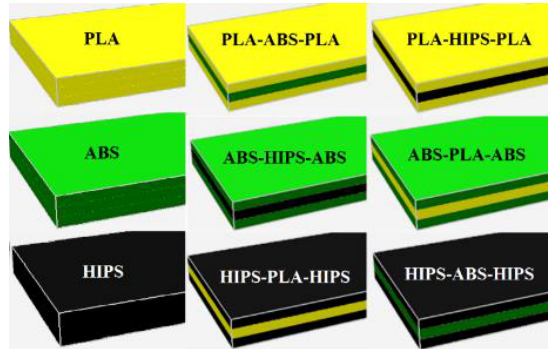
Figure 2. Geometry for a typical specimen as a single material and as a sandwich structure part (three sections with equal thickness).